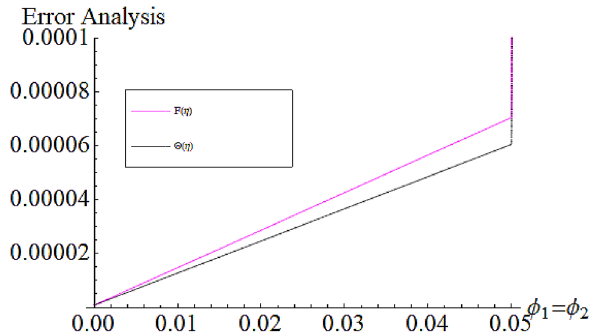
Figure 25. Parameter range φ 1 , φ 2 .